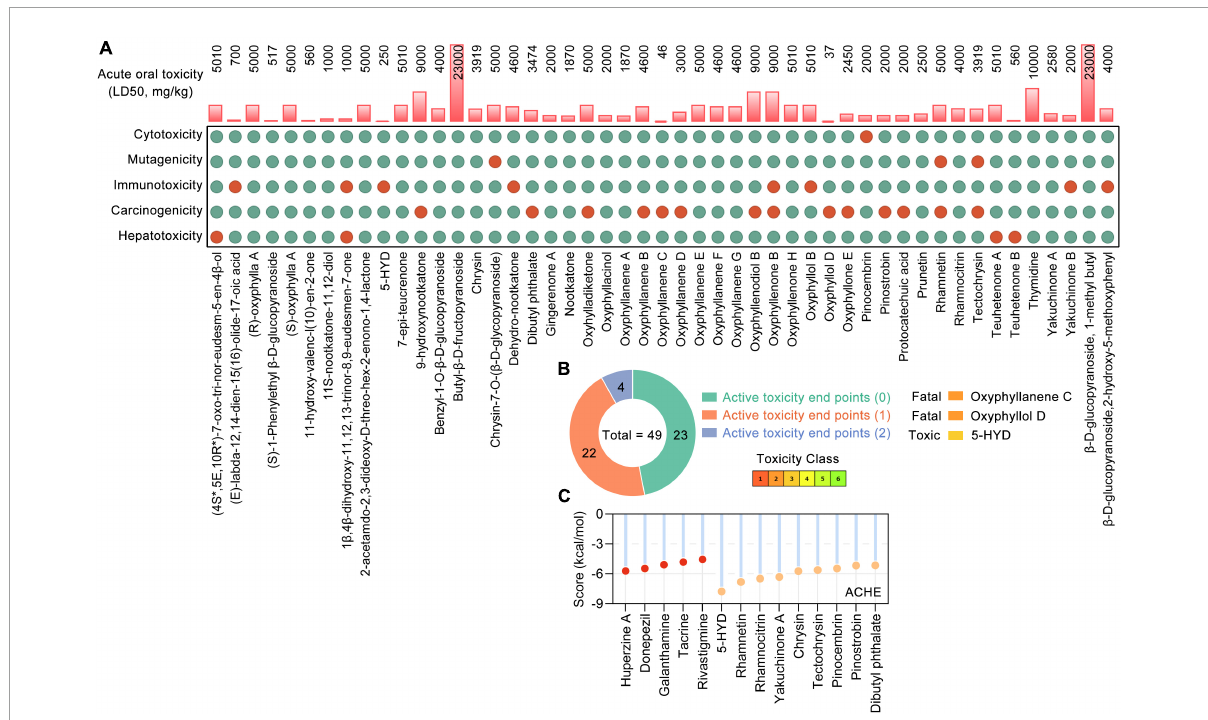
FIGURE1 The toxicological parameters of 49 bioactive phytochemicals in Alpinia oxyphylla Miq (AO). (A) The toxicological parameters including the acute oral toxicity (LD50, mg/kg), hepatotoxicity and toxicological endpoints (carcinogenicity, immunotoxicity, mutagenicity, and cytotoxicity) in AO. Red and green circles represent active or inactive, respectively. (B) Numbers of phytochemical with 0 (green), 1 (orange), and 2 (blue) active toxicity endpoints among 49 AO phytochemicals. (C) Molecular docking of ACHE with AO phytochemicals and 5 clinically used acetylcholinesterase (ACHE)